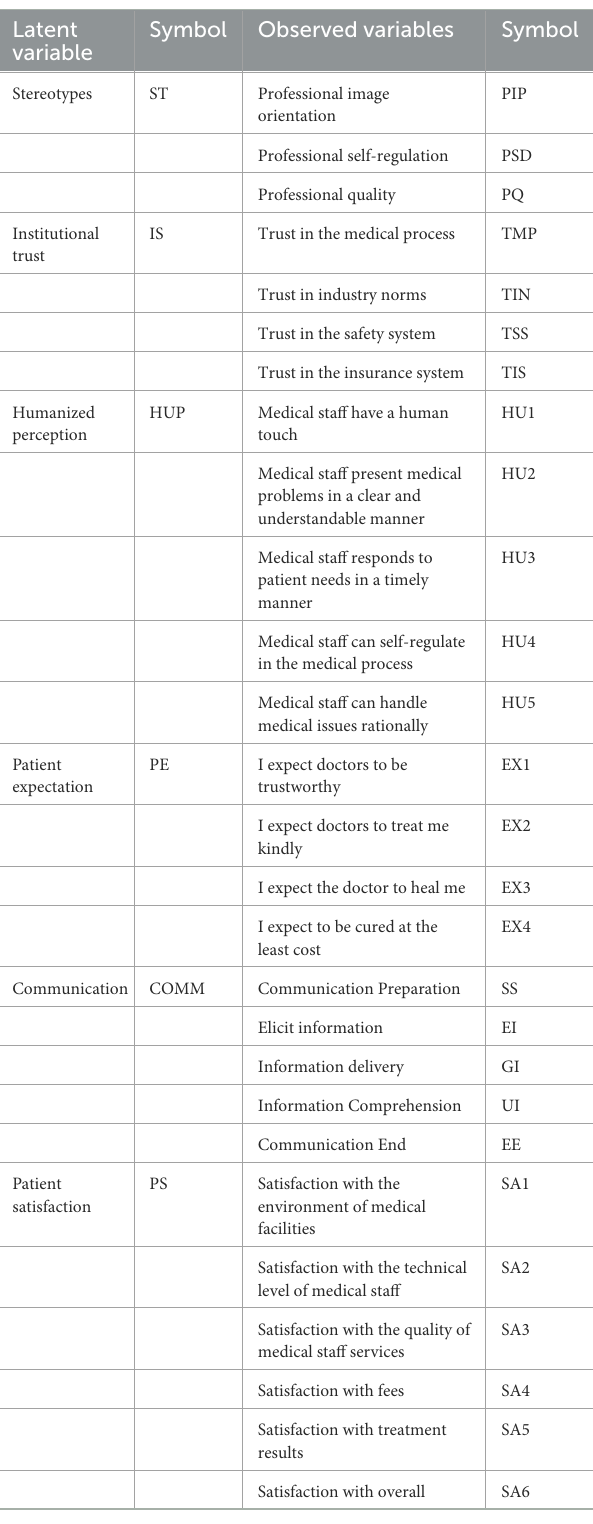
TABLE 4 Lists of latent and explicit variable